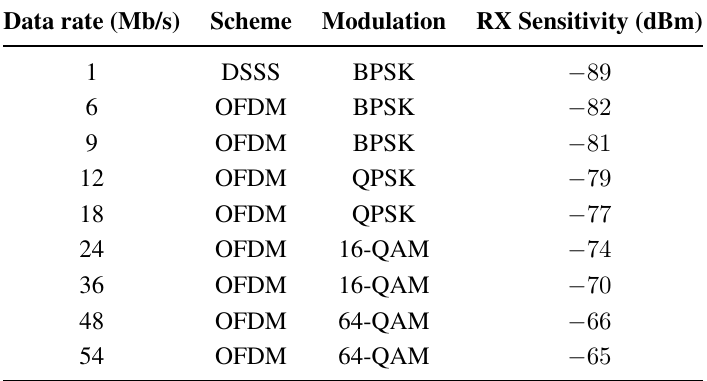
Table 1. Relationship between modulation, data rate and receiver sensitivity defined by the IEEE 802.11 b/g standard (see [31]). DSSS, Direct Sequence Spread Spectrum; BPSK, Binary Phase-Shift Keying; OFDM, Orthogonal Frequency-Division Multiplexing; QPSK, Quadrature Phase-Shift Keying;QAM, Quadrature Amplitude modulation.